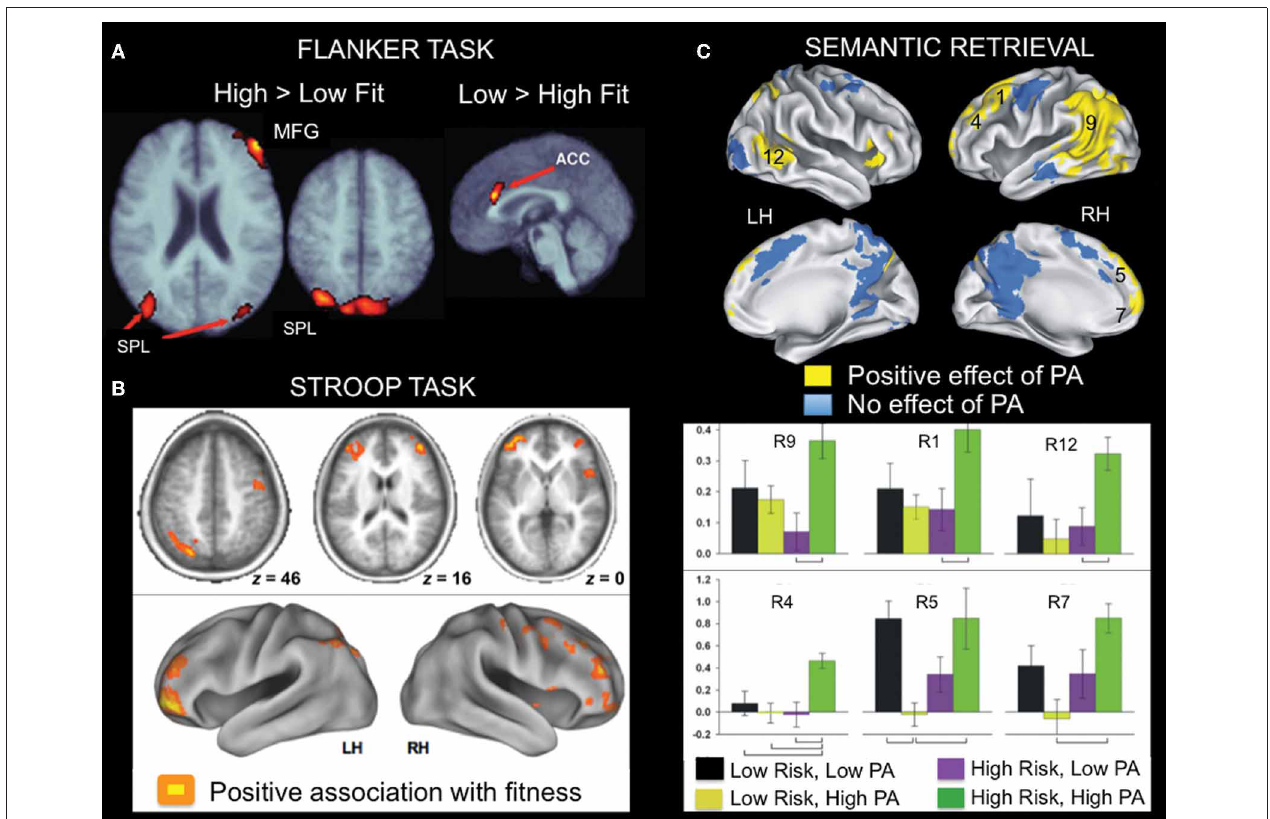
FIGURE 5 | Examples of fMRI studies showing a positive relationship between brain activity and aerobic fitness across a variety of cognitive tasks. (A) Lateral fronto-parietal regions showed increased activation, whereas anterior cingulate cortex showed reduced activation during flanker task performance as a function of fitness in older adults. This pattern was evident in both a cross-sectional and an exercise intervention training study. From Colcombe et al. (2004), Figure 2, p. 3318. Adapted with permission. (B) During Stroop task performance, increased activation in lateral fronto-parietal regions was associated with